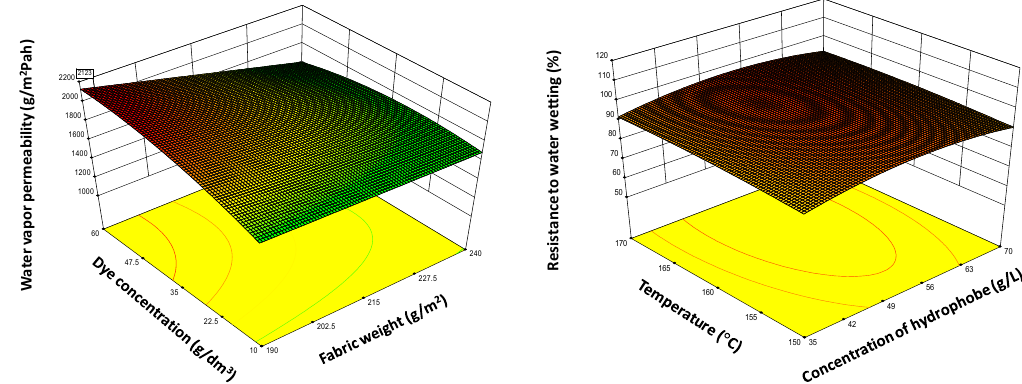
Figure 10. Response surface of the Central composite design, optimized response variables for: water vapor permeability and resistance to water wetting.